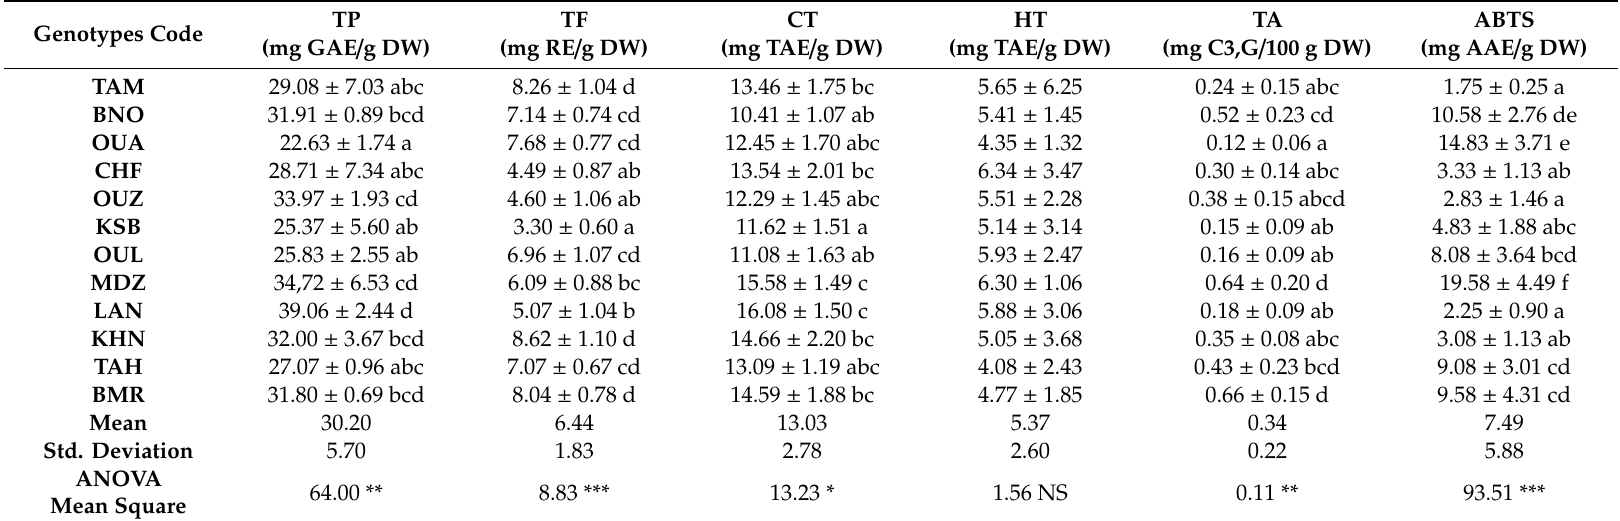
Table 3. Phenolic compound (total phenols, total flavonoids, total anthocyanins, condensed and hydrolyzable tannins) and IC50 value of ABTS of twelve strawberry